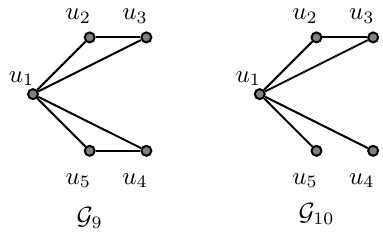
Figure 6: The graphs G